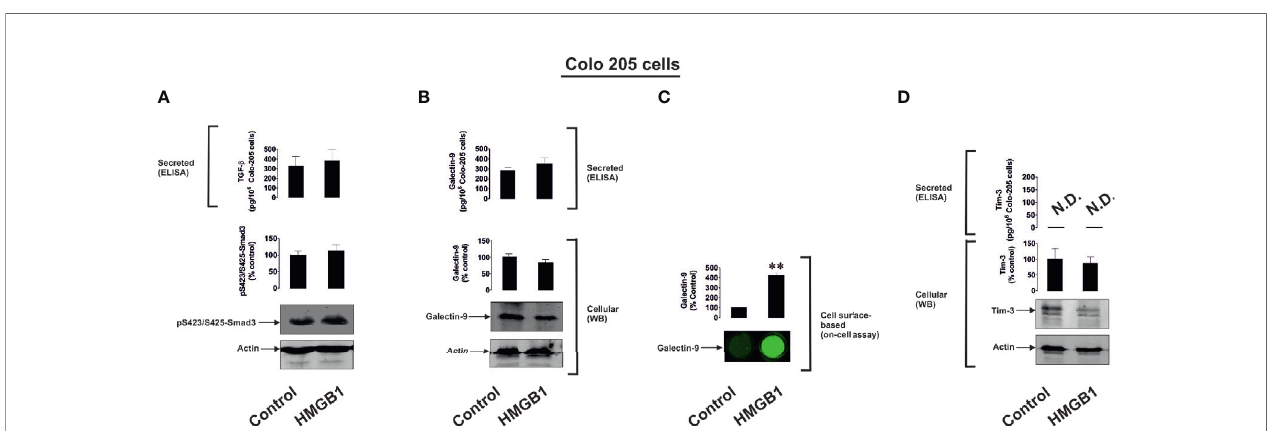
FIGURE 3 | The effects of HMGB1 on Galectin-9 and Tim-3 expression in Colo 205 human colorectal cancer cells. Colo 205 cells were exposed for 24 h to 1 µg/ml HMGB1 followed by measurement of TGF- b secretion and Smad3 activating phosphorylation (A) , galectin-9 protein expression and secretion (B) , galectin-9 cell surface presence (C) and Tim-3 protein expression and release (D) . Images are from one experiment representative of four which gave similar results. Quantitative data are expressed as mean values ± SEM of four independent experiments. **p < 0.01 vs control. N.D. in this and other fi gures denotes “ not detectable ”